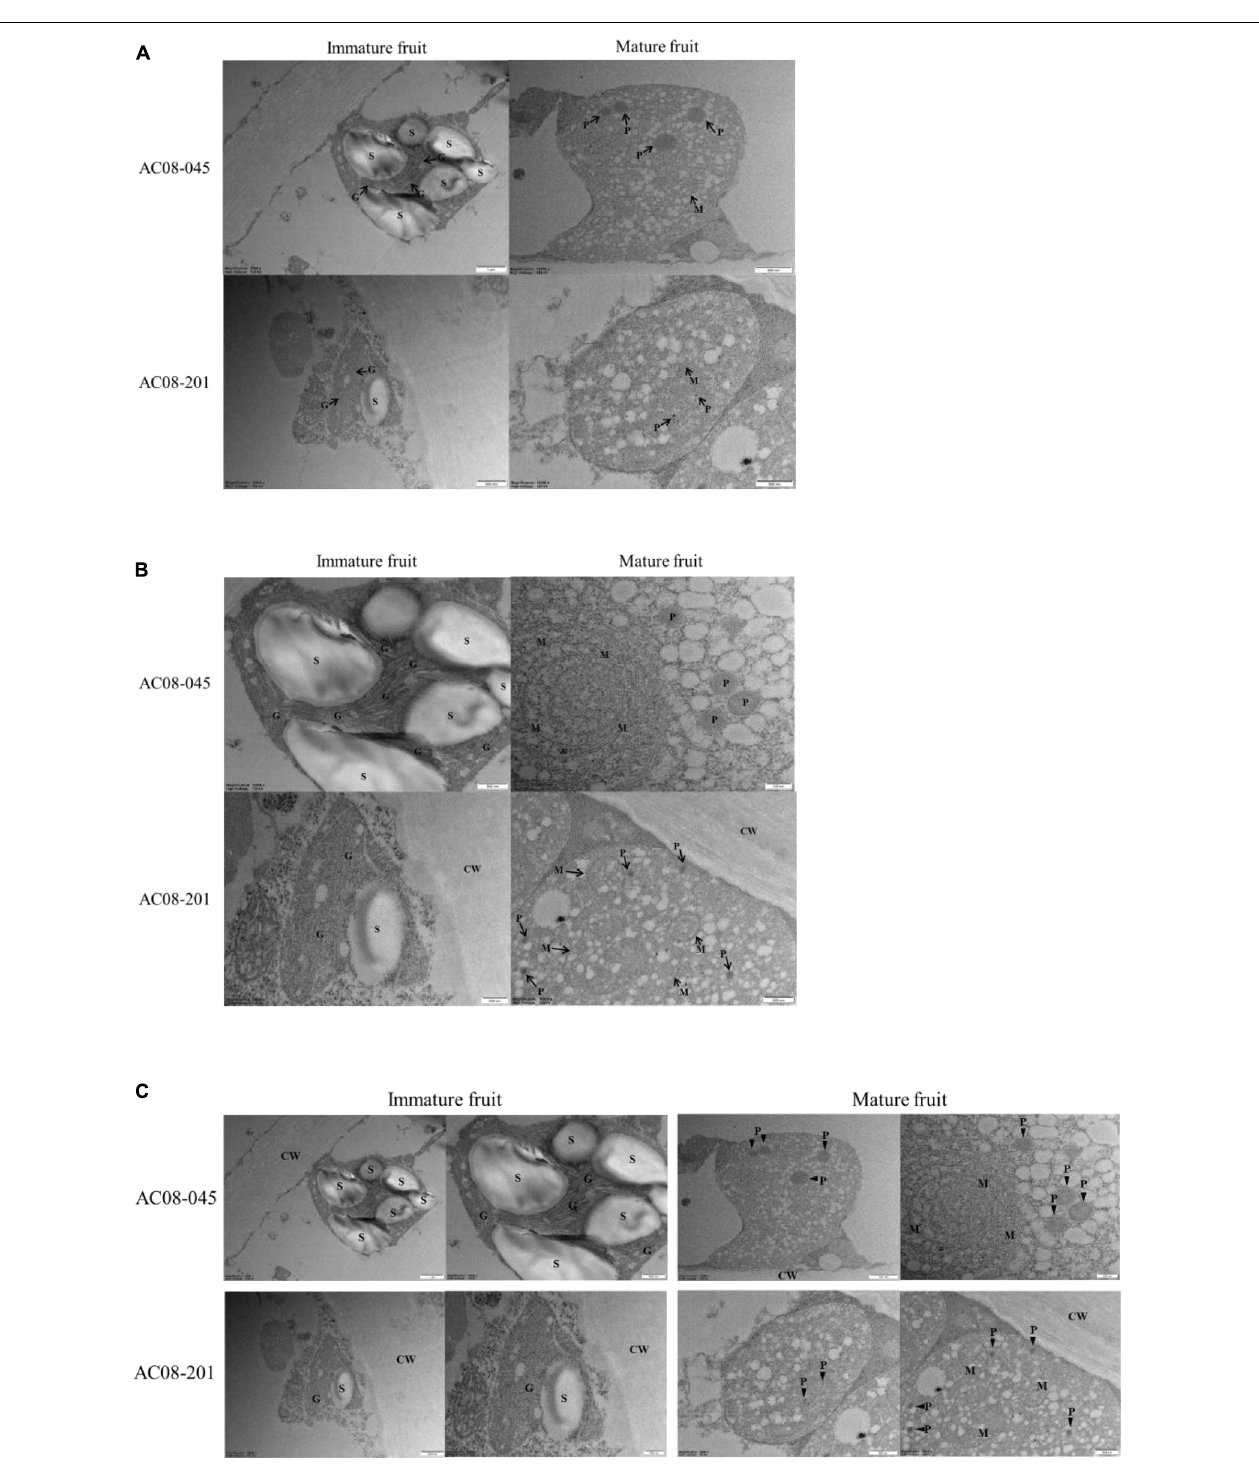
FIGURE 4 | Plastid structures of AC08-045 and AC08-201 observed by TEM. (A–C) Chloroplast of immature fruits and chromoplast of mature fruits were observed. (A) Images of single plastids of immature and mature fruits of AC08-045 and AC08-201, shown in wide field. (B) Magnified images showing inner structures of each plastid. (C) Combined image of A and B for comparison. S, starch grain; CW, cell wall; G, granum; P, plastoglobule; M, internal membrane structure. Scale bars for each micrograph are located at the bottom right.